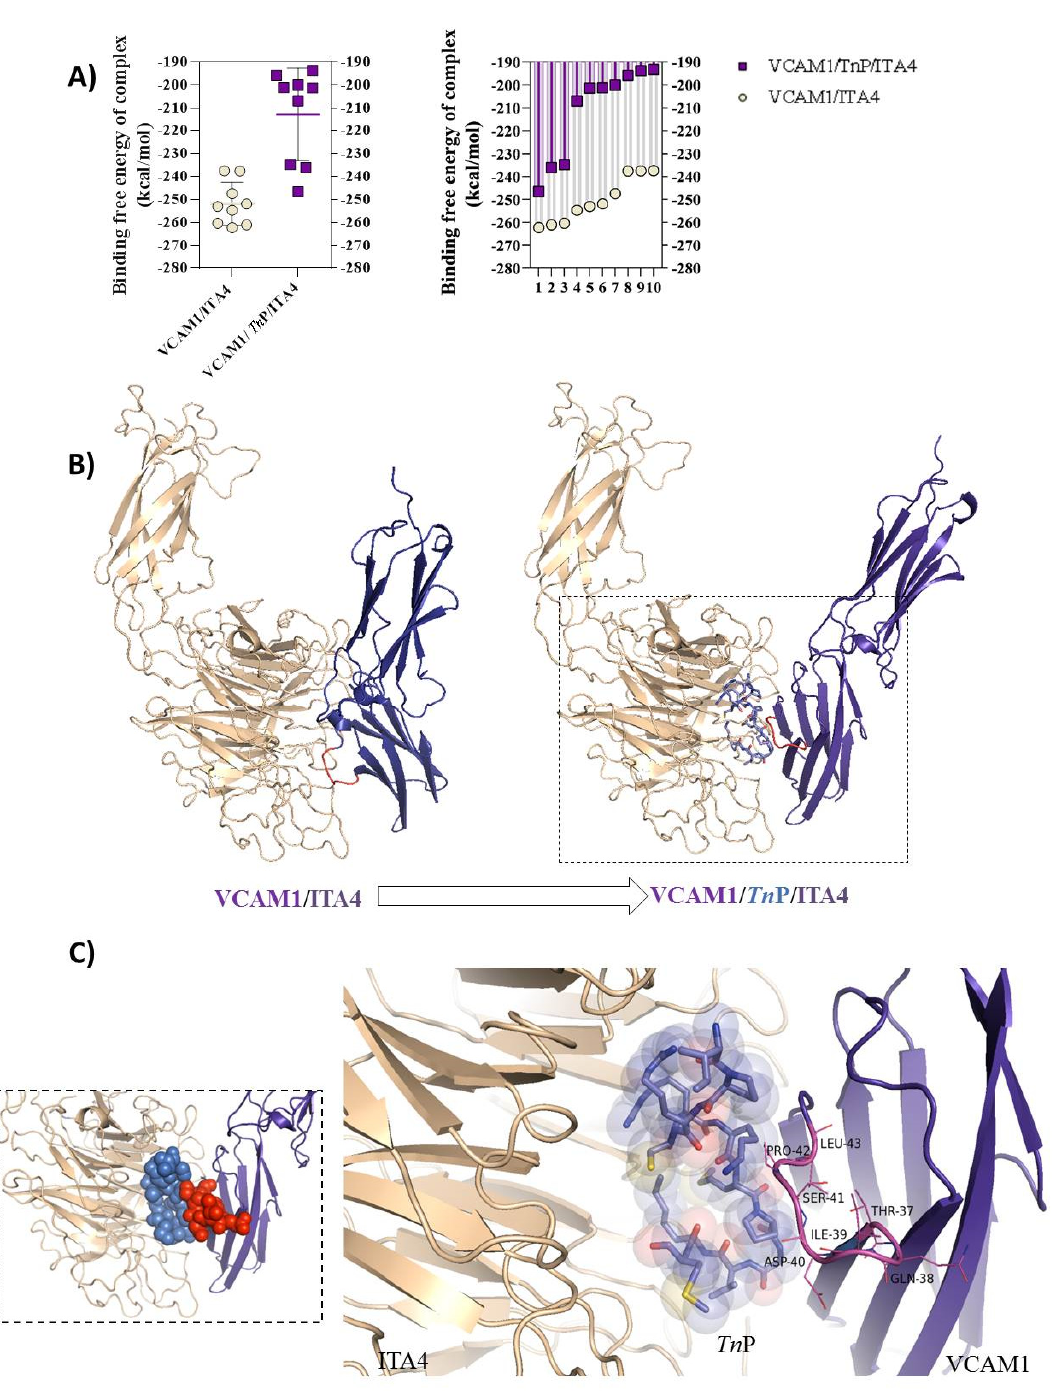
Figure 3. Model of the ITA4/VCAM-1 and ITA4/ Tn P/VCAM-1 complex interactions: ( A ) docking showing the free energy of binding complex expressed in kcal/mol values of 10 models simulated on the Hdock Serve platform (http://hdock.phys.hust.edu.cn/ accessed on 9 May 2022) of the ITA4/VCAM-1 complex and ITA4/ Tn P/VCAM-1 (on the left ), and on the right , we observe the 10 main interactions of each complex analyzed separately; ( B ) a 3D cartoon structure of the ITA4/ Tn P/VCAM-1 complex showing the main amino acids in the ITA4/VCAM-1 interaction re- sponsible for binding to the ITA4 activity site in red, and in the square, we observe the Tn P blockade in the ITA4/VCAM-1 interaction; ( C ) details of the ITA4/ Tn P/VCAM-1 complex and essential amino acids for active binding of the ITA4/VCAM-1 complex. The PDB file ITA4 and VCAM-1 were acquired from SWISS-MODEL using the reference ITA4_HUMAN and